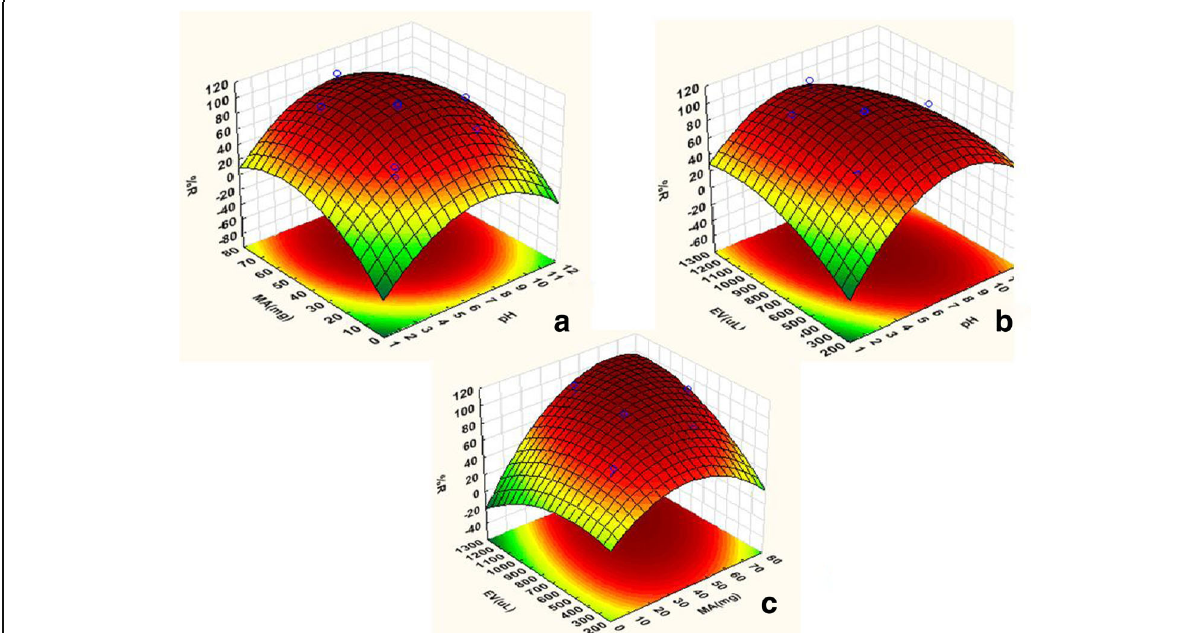
Fig. 8 Response surface and contour plots of the combined effects of a mass of adsorbent and pH, b eluent volume and pH, and c eluent volume and mass of